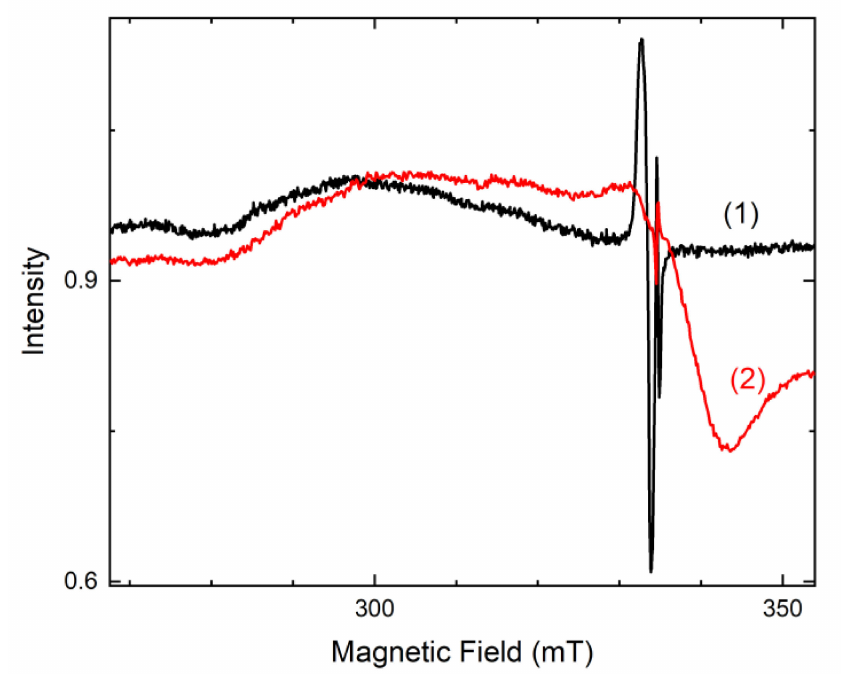
Figure 23. ESR spectra of biachellaite (Sample 14, curve 1) and marinellite sulfite analogue (curve